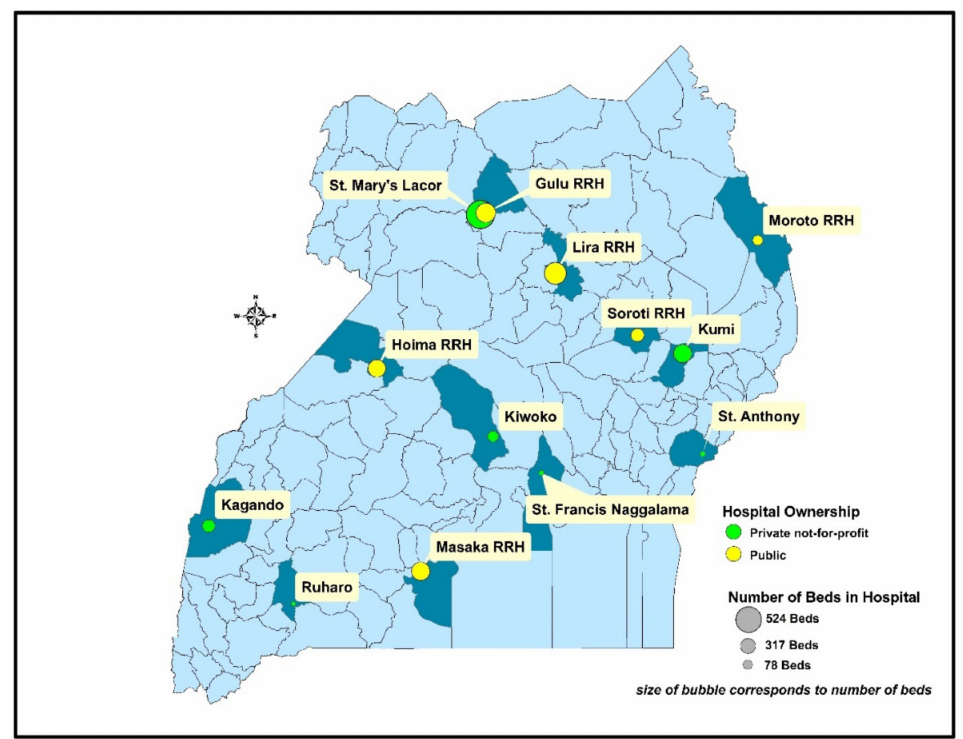
Figure 1. Geographic location of study sites and number of hospital